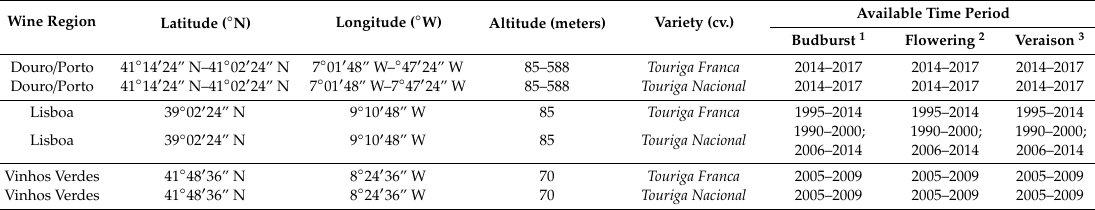
Table 1. Available time periods of the phenological data used in the present study (budburst, flowering and veraison dates) by wine region (Douro, Lisboa and Vinhos-Verdes) and for each grapevine variety (cv. Touriga Franca and cv. Touriga Nacional ). Wine Region Latitude ( ° N) Variety (cv.)